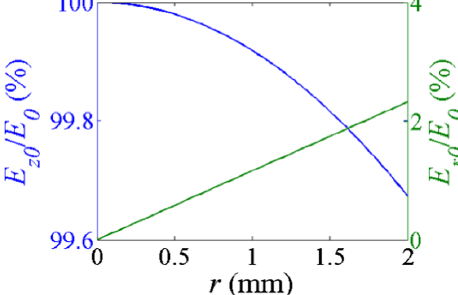
FIG. 1. Variations of E z 0 =E 0 and E r 0 =E 0 versus r for k 0 ¼ 46 . 47 and η 57 . 16 in an S-band accelerator cell. 0 ¼